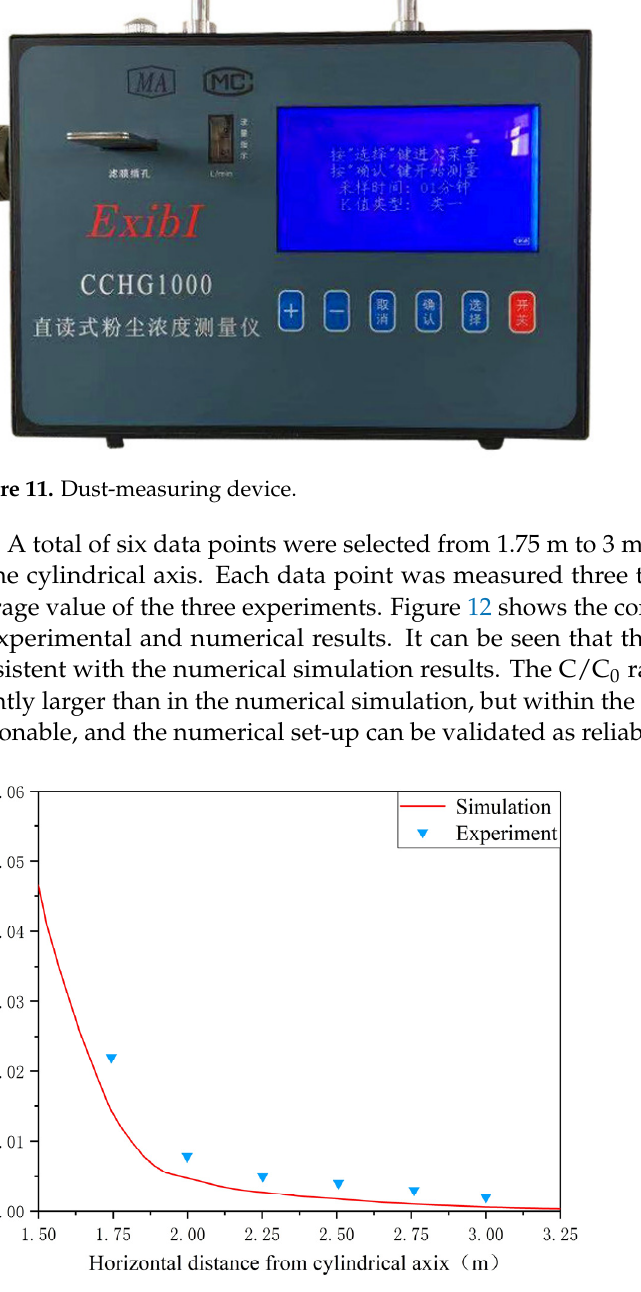
Figure 12. Comparison of dust concentration between simulation and experiment.